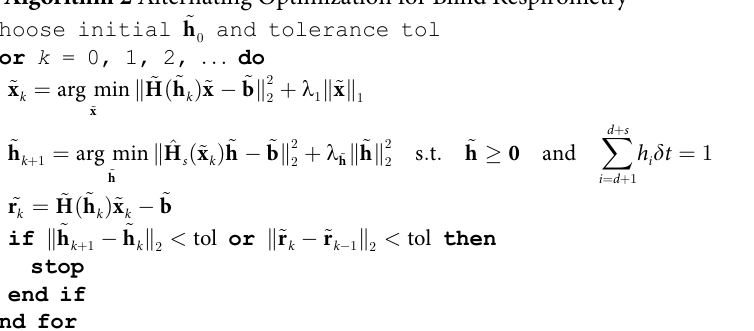
Algorithm 2 Alternating Optimization for Blind